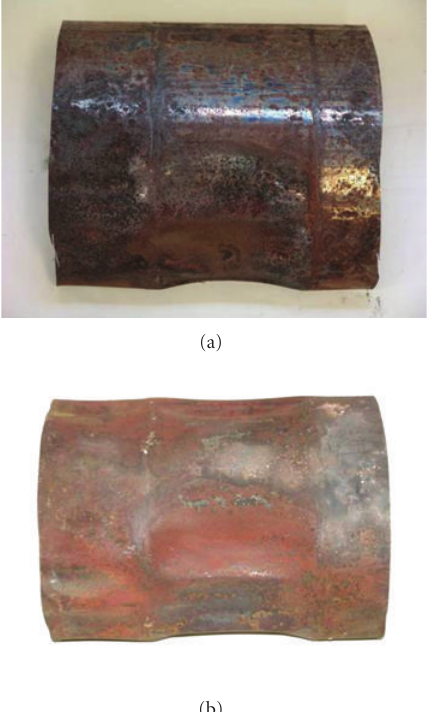
Figure 4: Comparison of field and tested system: (a) mu ffl er from field after 54878 km/6yrs and (b) mu ffl er after 6 weeks of testing.